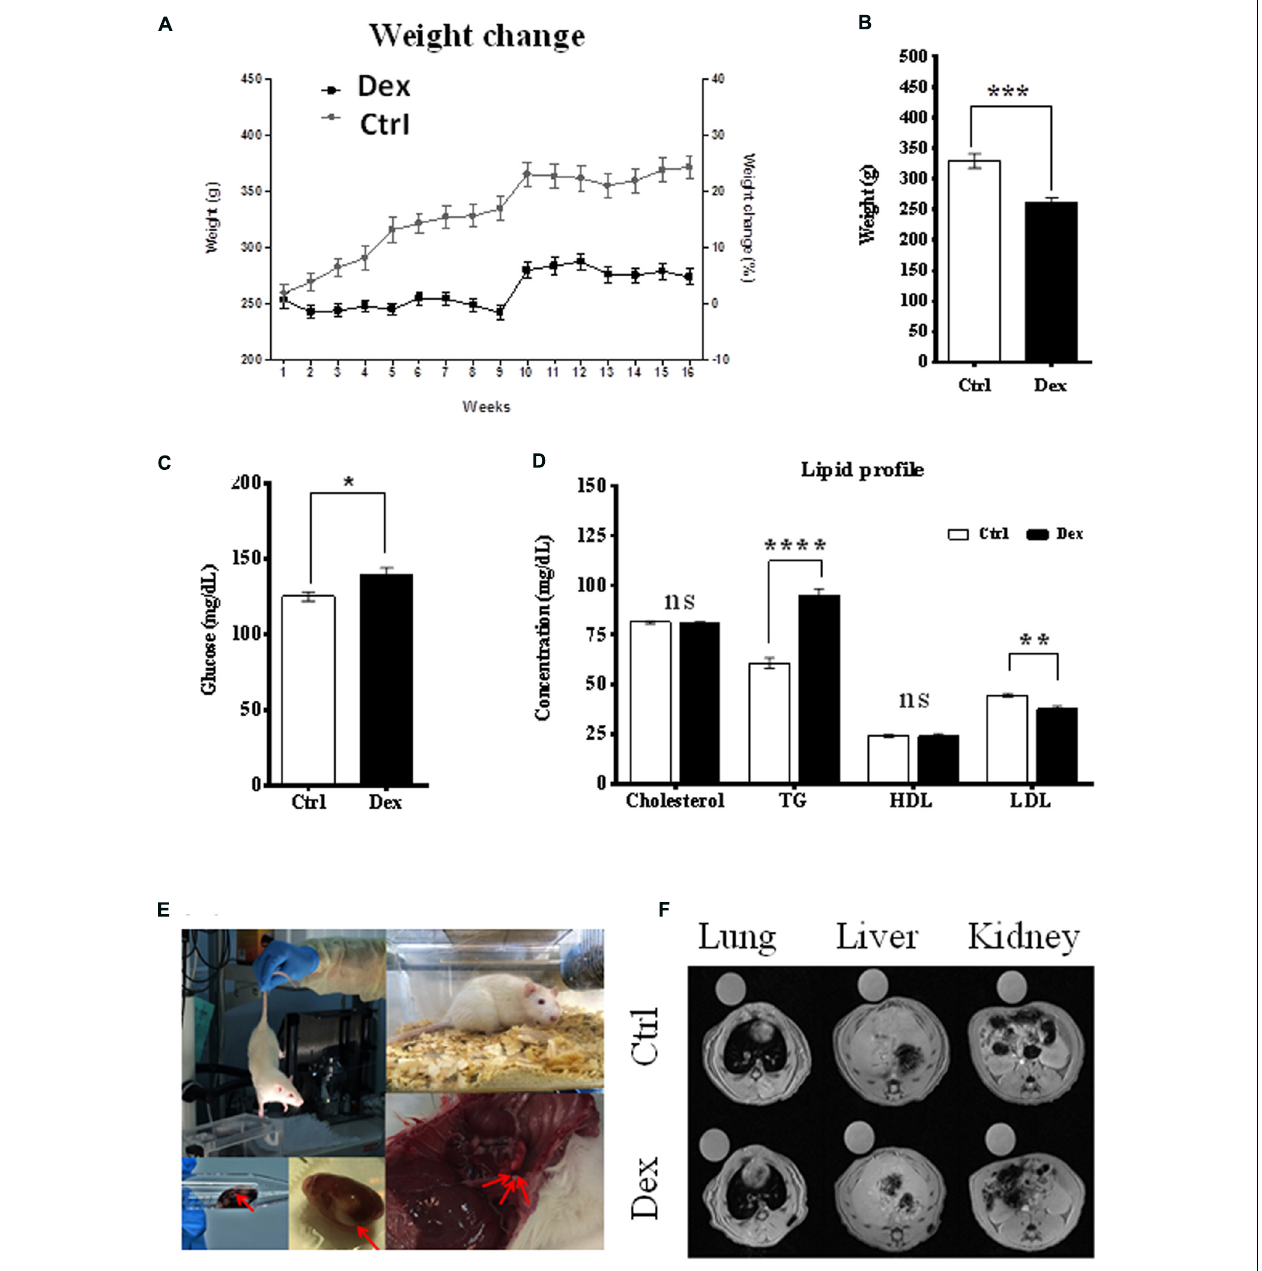
FIGURE 1 | Dexamethasone effect on rats phenotypes. (A) The difference in weight between Ctrl and Dex treated groups during the 16 weeks period, a reduction in age-dependent increase in weight is observed in Dex treated group compared to Ctrl. (B) A significant reduction in total weight of Dex treated group compared to Ctrl ( p -value 0.0002). (C) Significant effect of Dex treatment on blood glucose level ( p < 0.05). (D) Effect of Dex on lipid profile (Cholesterol, Triglycerides (TG), High-Density Lipoprotein (HDL), Low-density lipoprotein (LDL)) in Dex treated rats compared to Ctrl. No significant effect (ns) was found on total cholesterol and HDL levels ( p > 0.05); TG levels were significantly increased in Dex group ( p -value 0.0001) while LDL levels were significantly decreased ( p -value 0.001). p -values were calculated using unpaired student’s t -test, n = 10/group. (E) Changes in soft tissues in Dex treated rats. (F) Soft tissue MRI image (left) lung, (middle) liver, and (right) kidney and spleen in the Ctrl group and Dex treated groups.